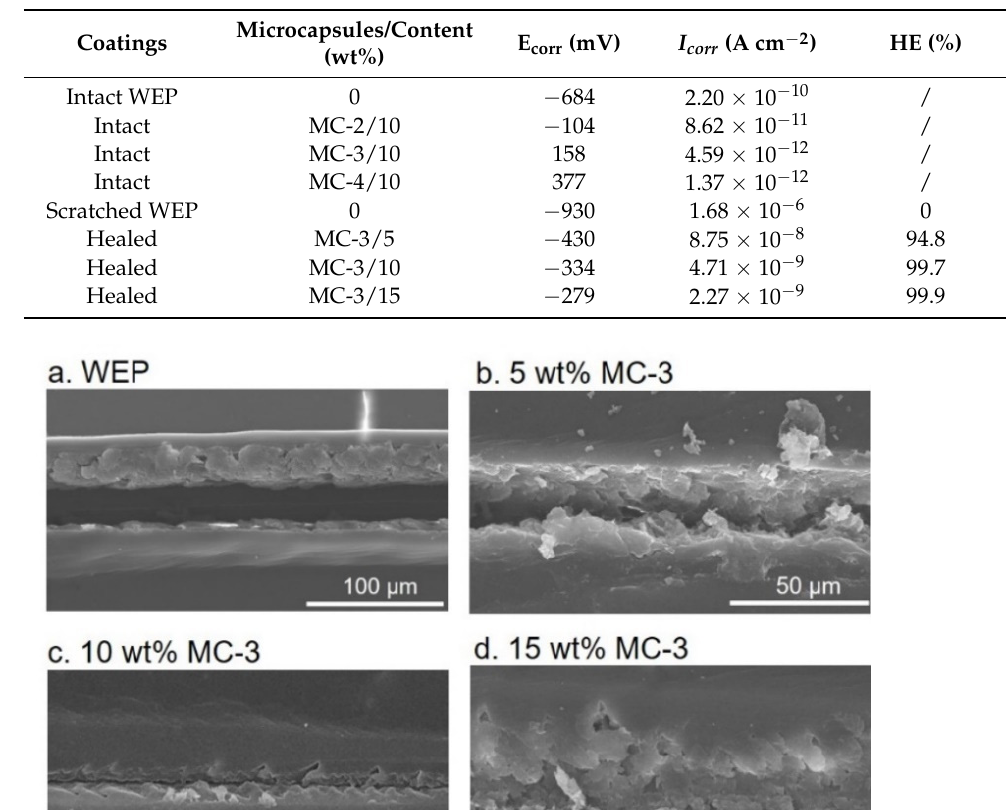
Figure 5. The Tafel plots of intact coatings containing 10 wt% of different GO microcapsules ( a ) and healed coatings containing different contents of MC-3 ( b ). Table 3. The electrochemical parameters for different coatings.